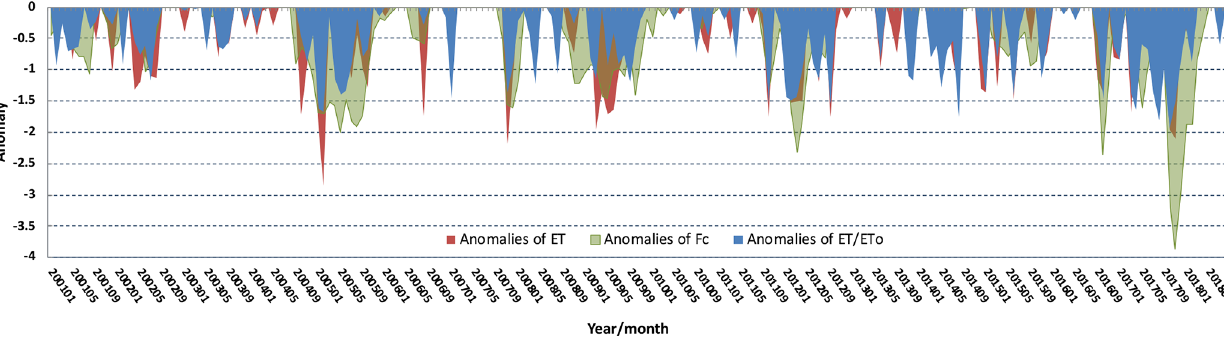
Figure 8. Comparison of monthly negative anomalies of ET, ET / ET o and f c for the entire oak savanna area of the Iberian Peninsula from January 2001 to August